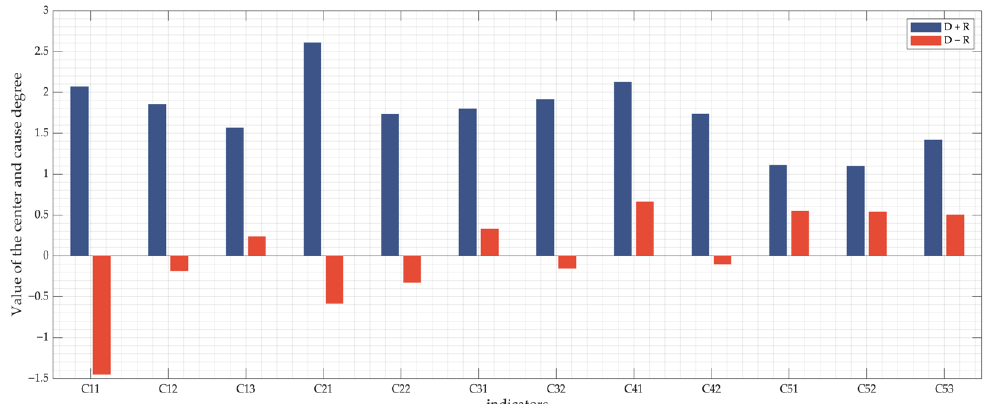
Figure 5. Calculation results for centrality and causality.